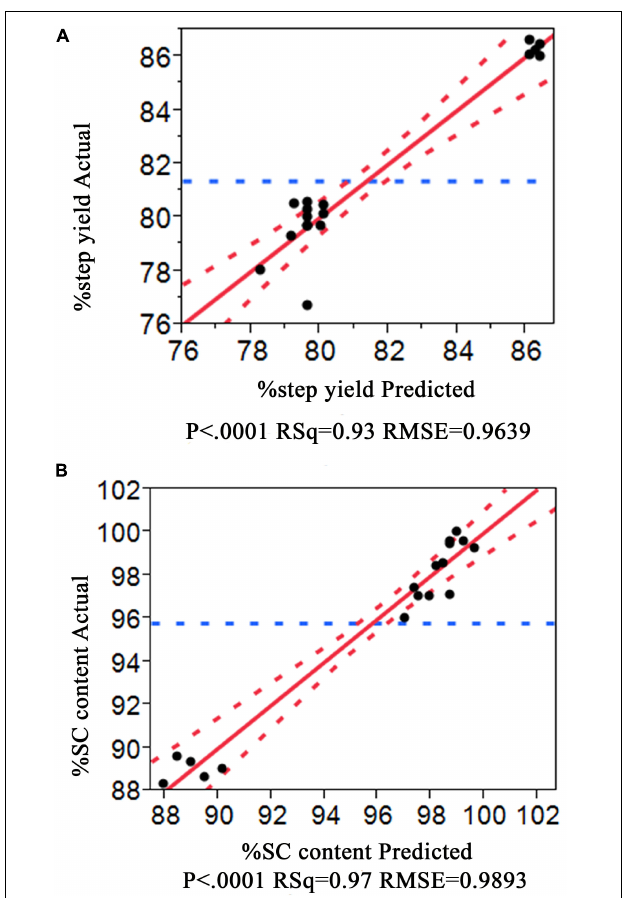
FIGURE 2 | Prediction plot for %Step yield (A) and for %SC pDNA (B)